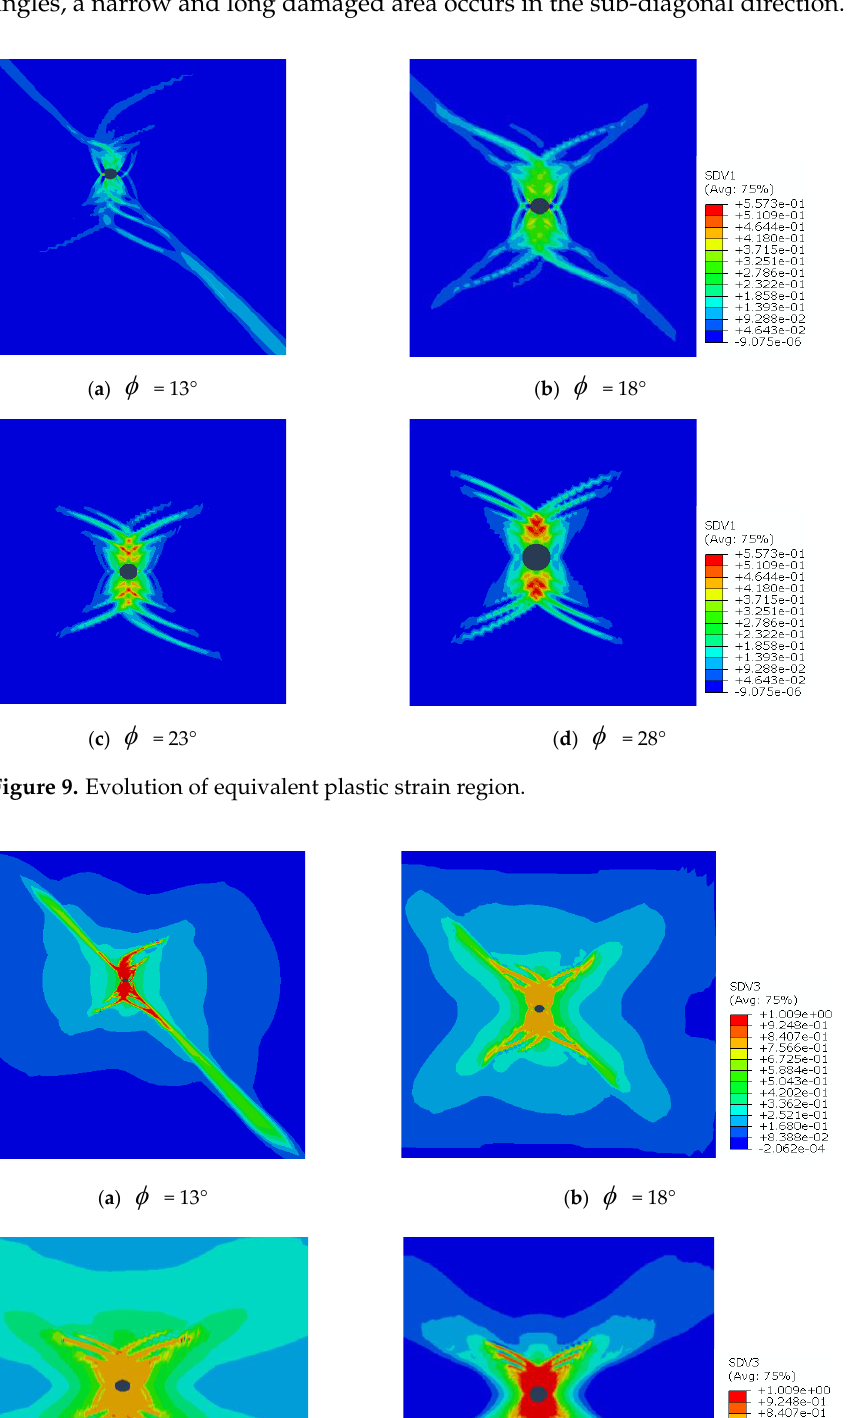
the nodal path are shown in Figure 11. As the distance from the borehole increases, the rock permeability, disturbance damage factor, and equivalent plastic strain show a de- creasing and fluctuation trend, indicating the heterogeneous damage features.